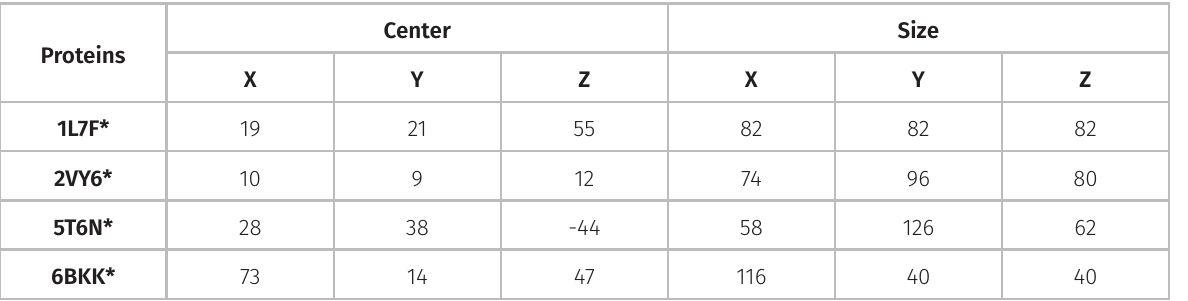
Table I. Grid parameters of studied Influenza proteins. Center Proteins